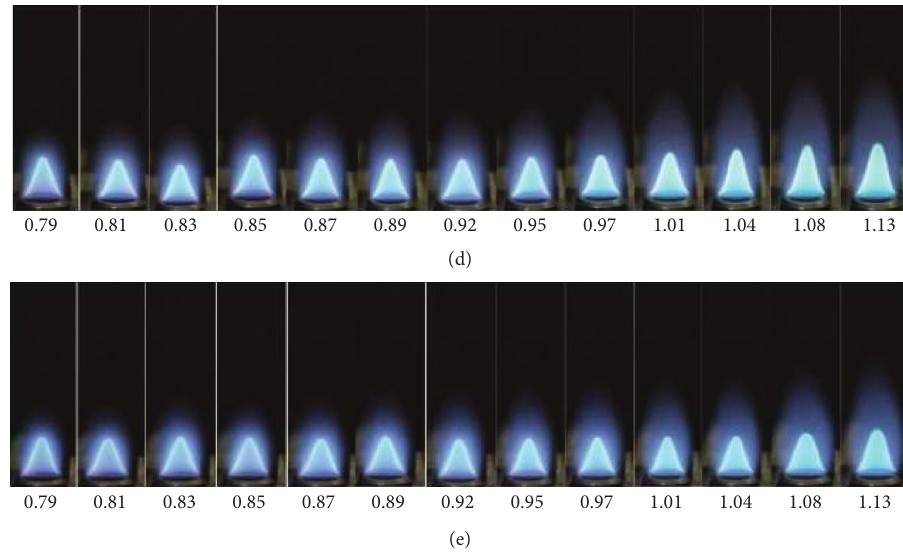
Figure 5: Stability and shape of the flame of jatropha oil at equivalence ratio: (a) without magnet; (b) magnet S-S; (c) magnet N-N; (d) magnet S-N; (e) magnet N-S.